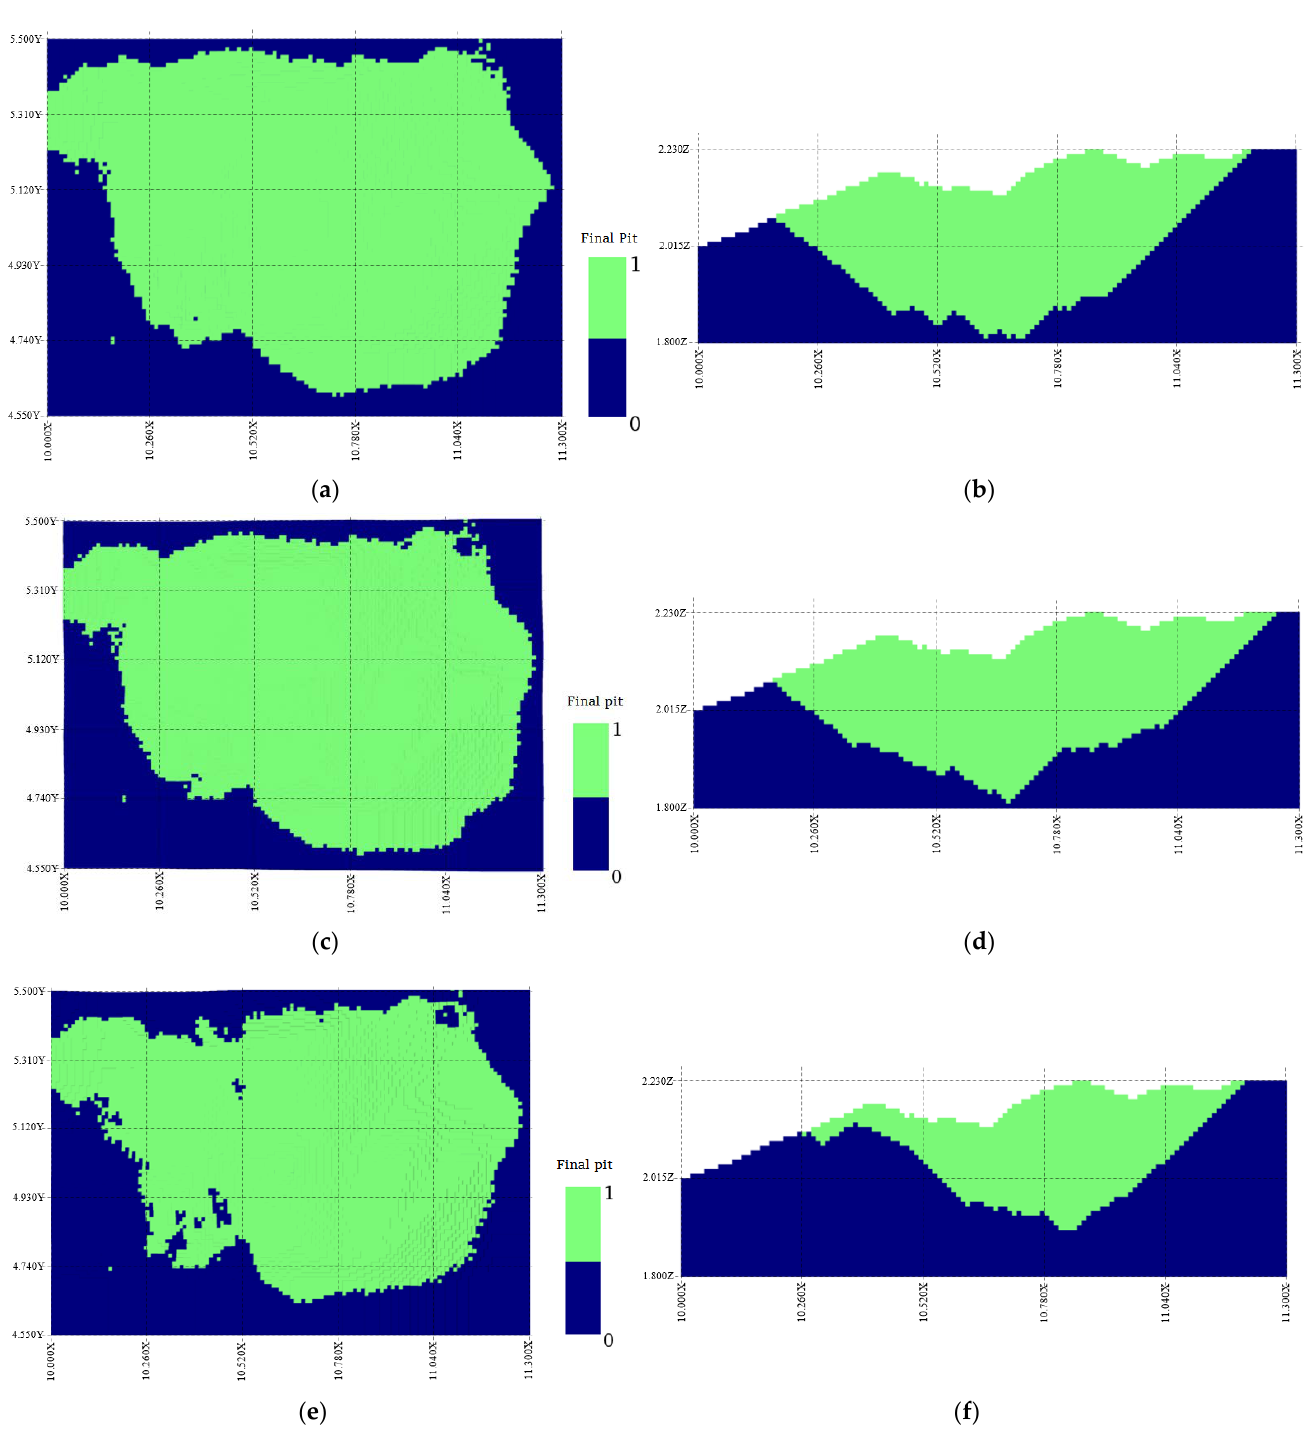
Figure 8. Views of final pit alternatives for the model BMT considering different parameter values µ = 200, 125, 25 [MUSD] and a confidence level δ = 95%. ( a ) plan view, final pit µ = 200; ( b ) 5030 m–NS view, final pit µ = 200; ( c ) plan view, final pit µ = 125; ( d ) 5030 m–NS view, final pit µ = 125; ( e ) plan view, final pit µ = 25; ( f ) 5030 m–NS view, final pit µ =